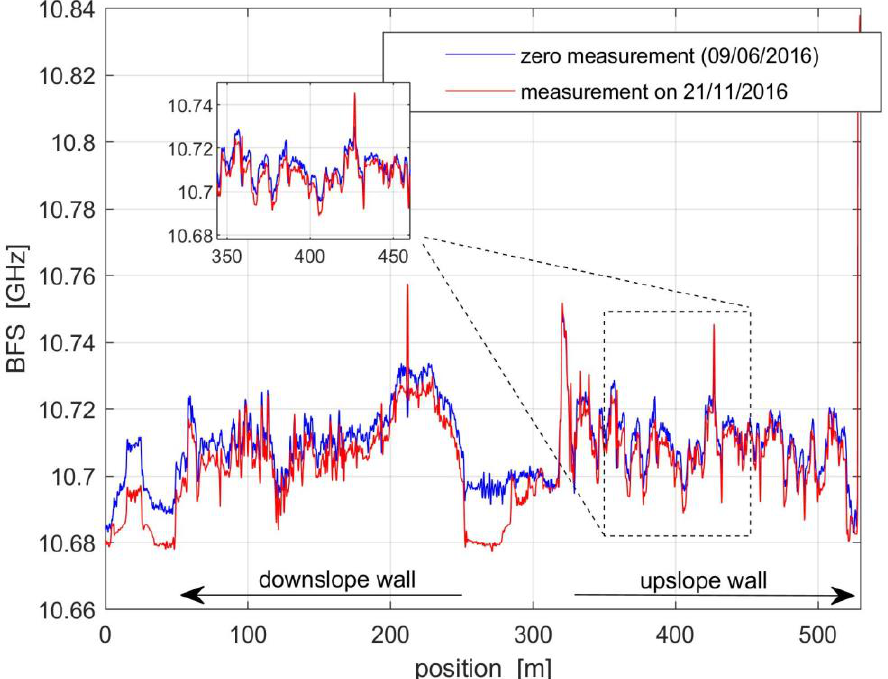
Figure 8. BFS measurements taken on 6 June 2016 (blue line) and 21 November 2016 (red line). The inset shows a zoomed view of the acquired BFS profiles from ≈ 350 m to ≈ 450 m.